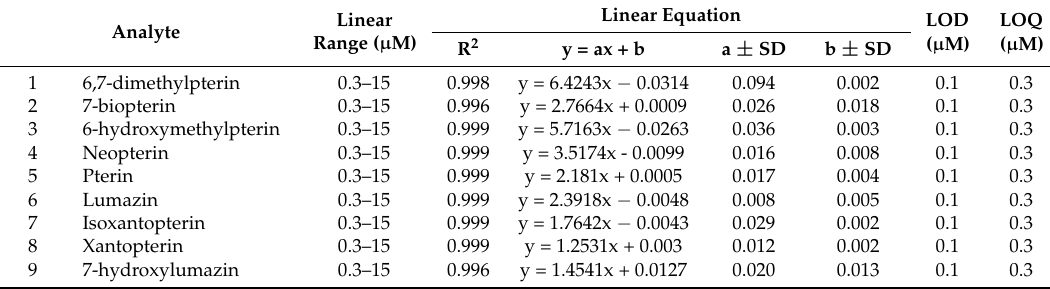
Table 1. Analytical figures of